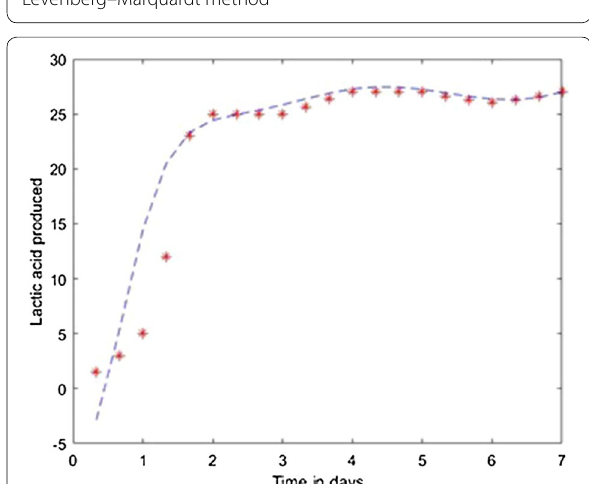
Fig. 12 Simulation of the model on 40% glycerol 60% LGJ for Levenberg–Marquardt method